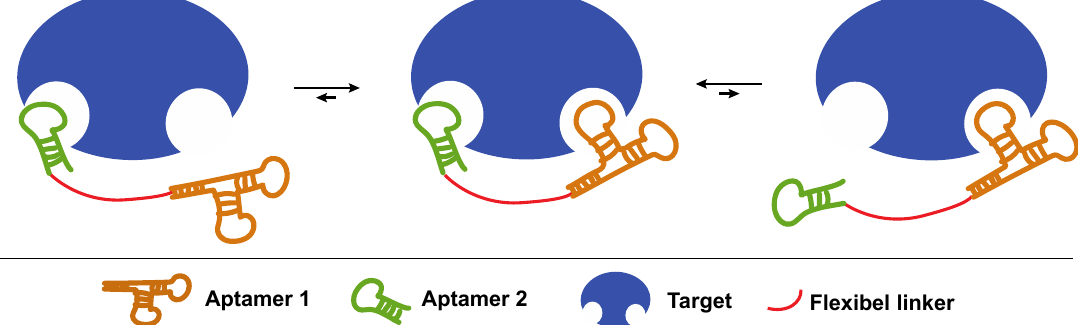
Figure 4. Principle of avidity explained for a bivalent aptamer towards a multimeric target. The dimeric aptamer construct consists of two aptamers conjugated by a flexible linker.